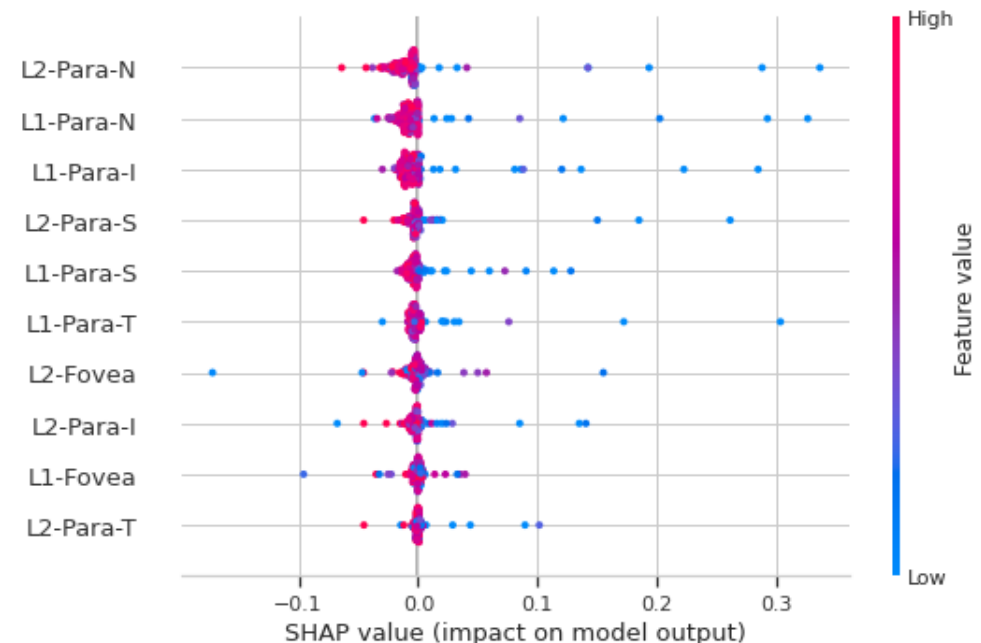
Figure 5. SHAP analysis summary plot for macular microvasculature density features. The color represents the value of the feature from low (red) to high (blue). The y-axis shows features ranked in descending order of importance. The x-axis shows the Shapley value and its impact on the model